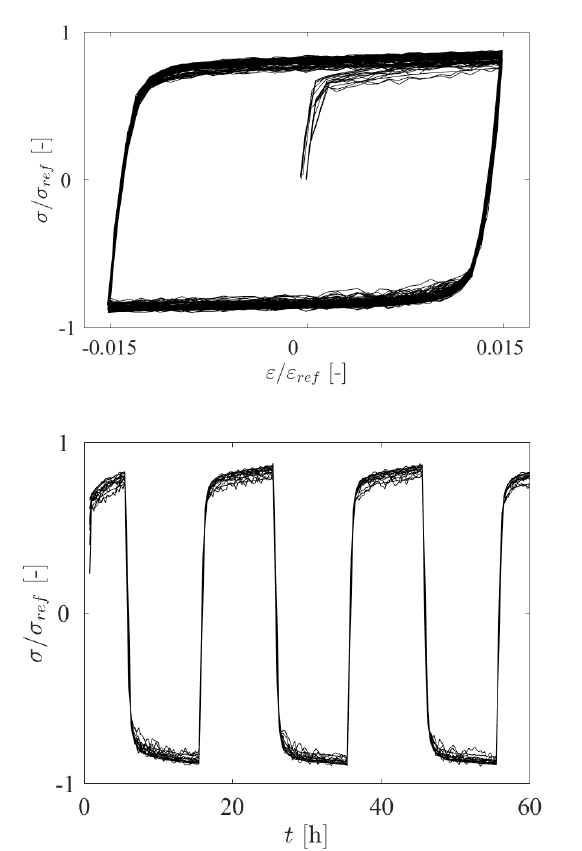
Figure 3. Experimental data: stress-strain curves.